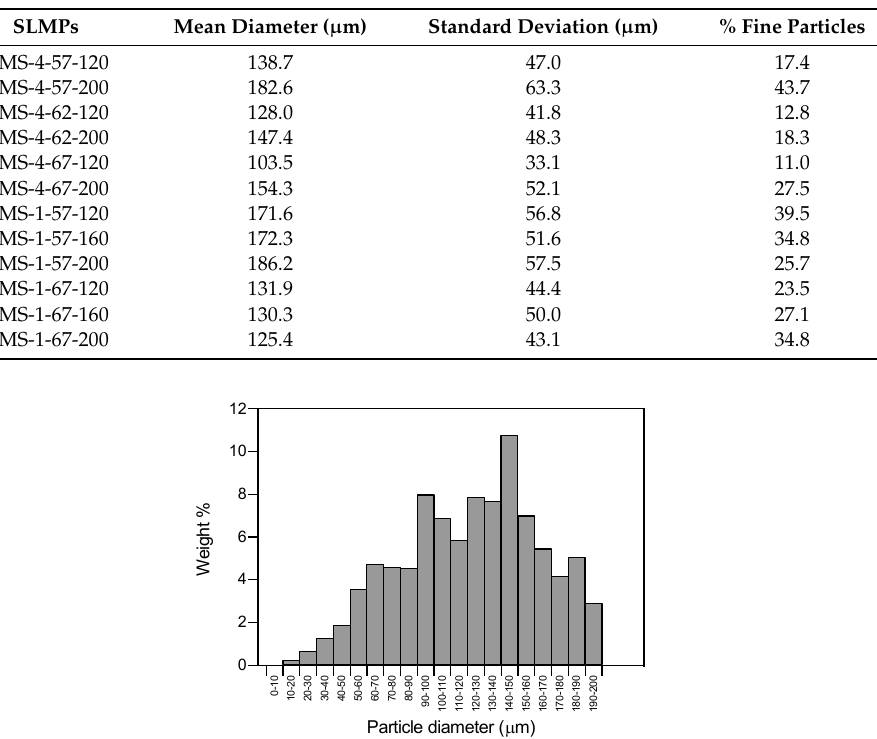
Table 1. Yield of particle production, mean diameter and standard deviation of SLMPs of GMS processed using PGSS ® technique. Particles were denoted as GMS-x-y-z, where x is the nozzle diameter (mm), y the processing temperature (degrees Celsius) and z the processing pressure (bar).